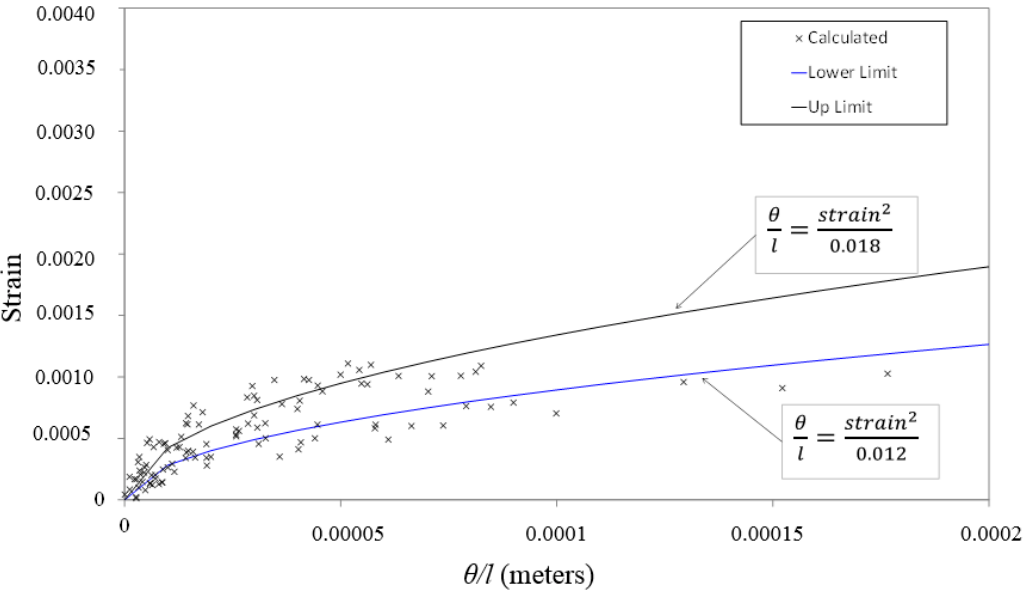
Figure 4. Relationship between strain and θ / l meters.